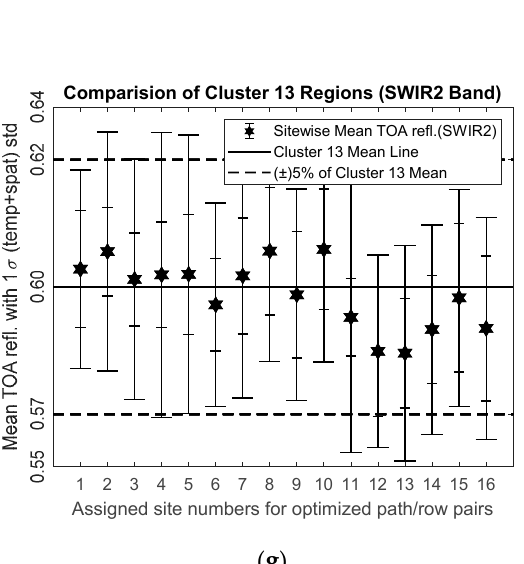
Figure 6. Mean temporal TOA reflectance values (with associated total standard deviations) of 16 individual Cluster 13 WRS-2 Path/Row(s): ( a ) CA band; ( b ) Blue band; ( c ) Green band; ( d ) Red band; ( e ) NIR band; ( f ) SWIR1 band; ( g ) SWIR2